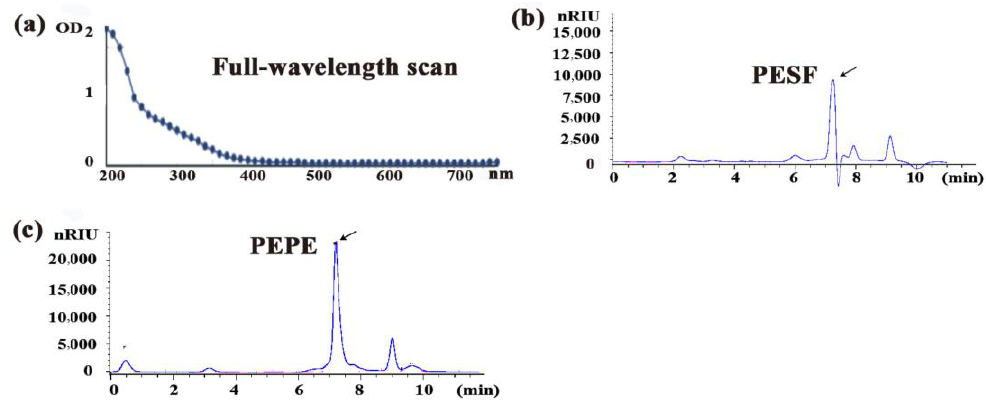
Figure 1. The full-wavelength scanning diagram from 200 to 700 nm ( a ) and the differential detection map of high-performance liquid chromatography ( b ) for the P. eryngii polysaccharide from mycelia solid-state fermentation (MSSF), using polysaccharide from fruiting bodies (PEPE) as a control ( c ).